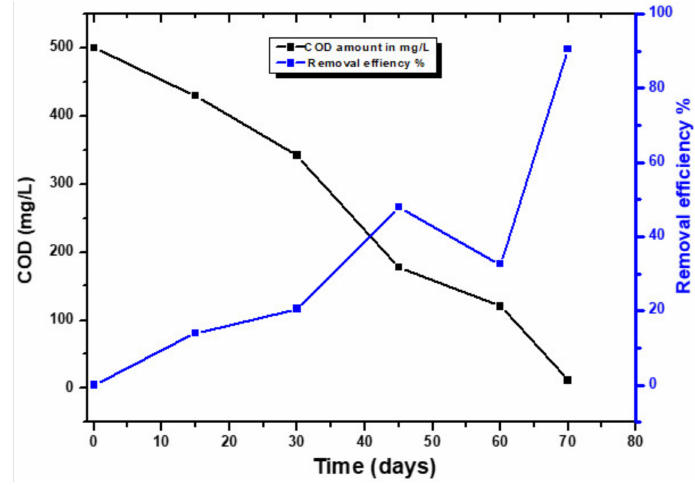
Figure 5. COD removal trend of the present study.